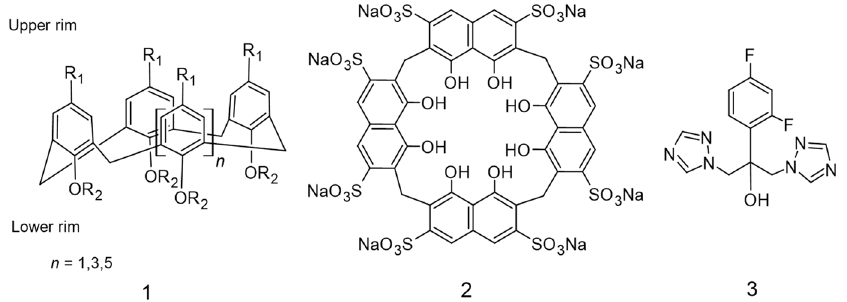
Figure 1. The structures of the calix[ n ]arene (1), sulfonatocalix[4]naphthalene (2), and fluconazole